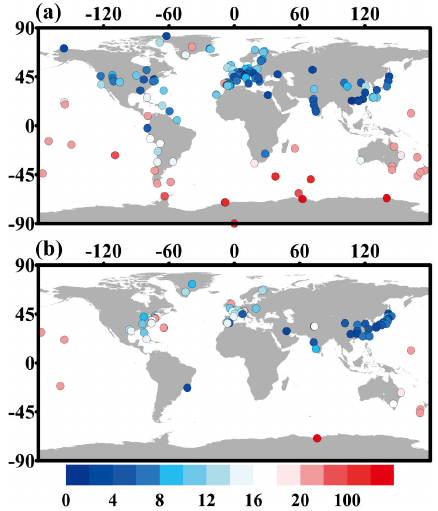
Figure 9. Global distribution of (a) 7 Be / 210 Pb activity ratio and (b) 7 Be / 210 Pb depositional flux ratio. Note that the color bar below applies to both figures.